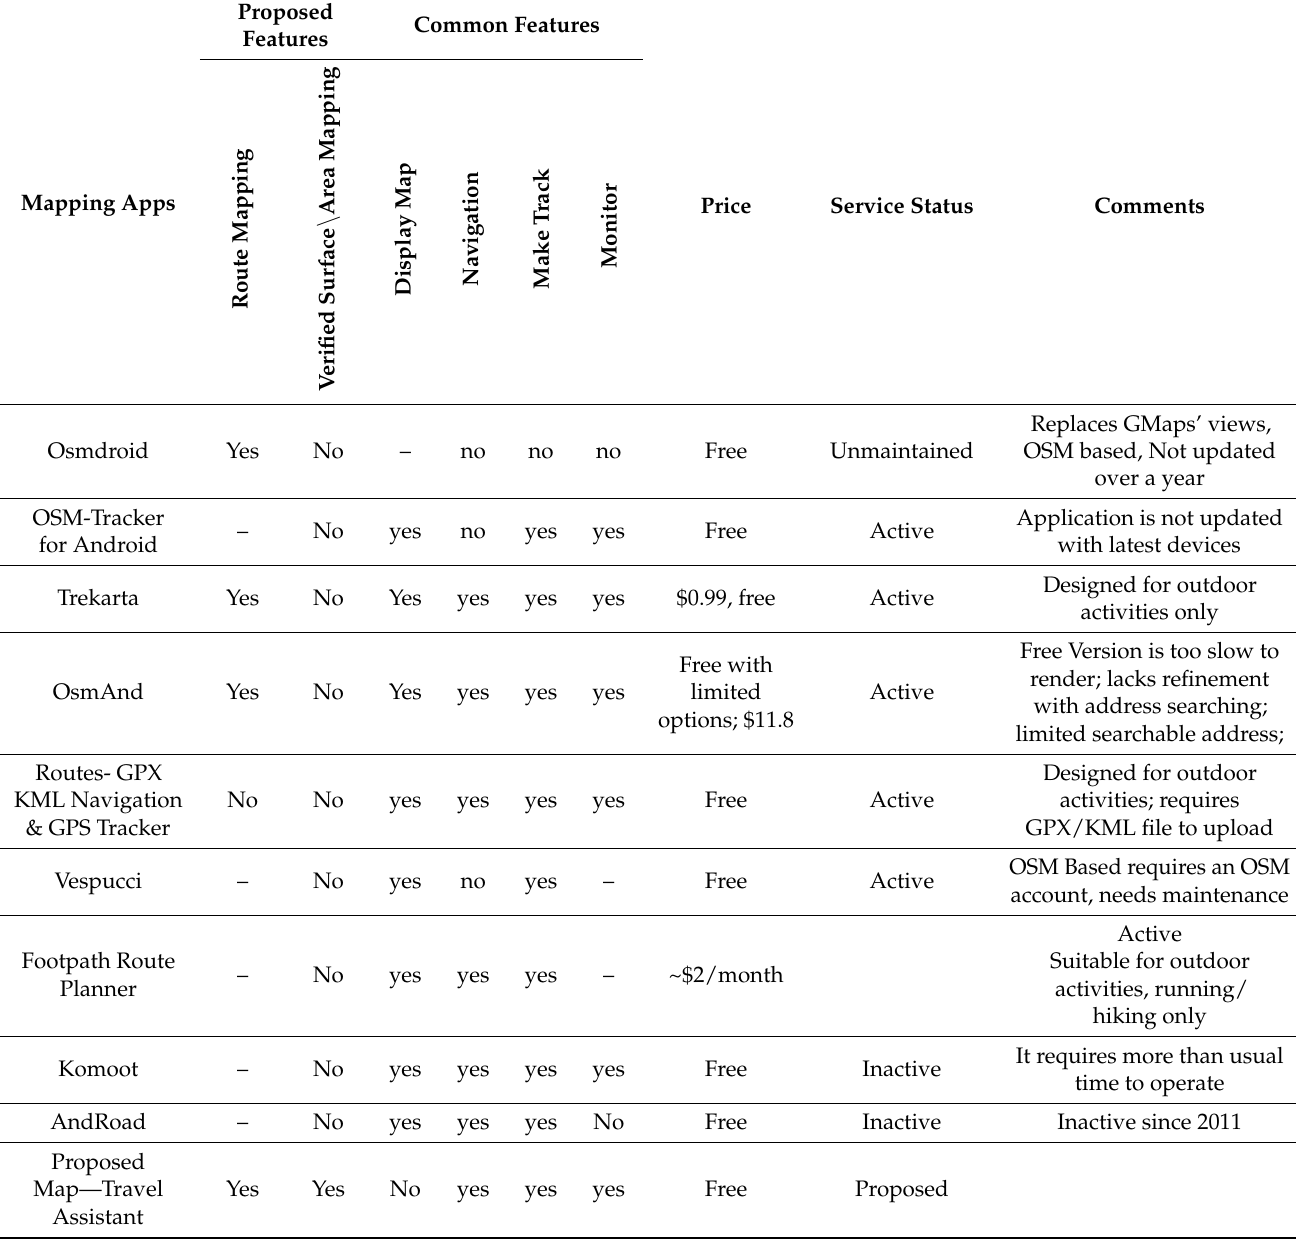
Table 4. Comparison between some similar mapping apps and the proposed mapping